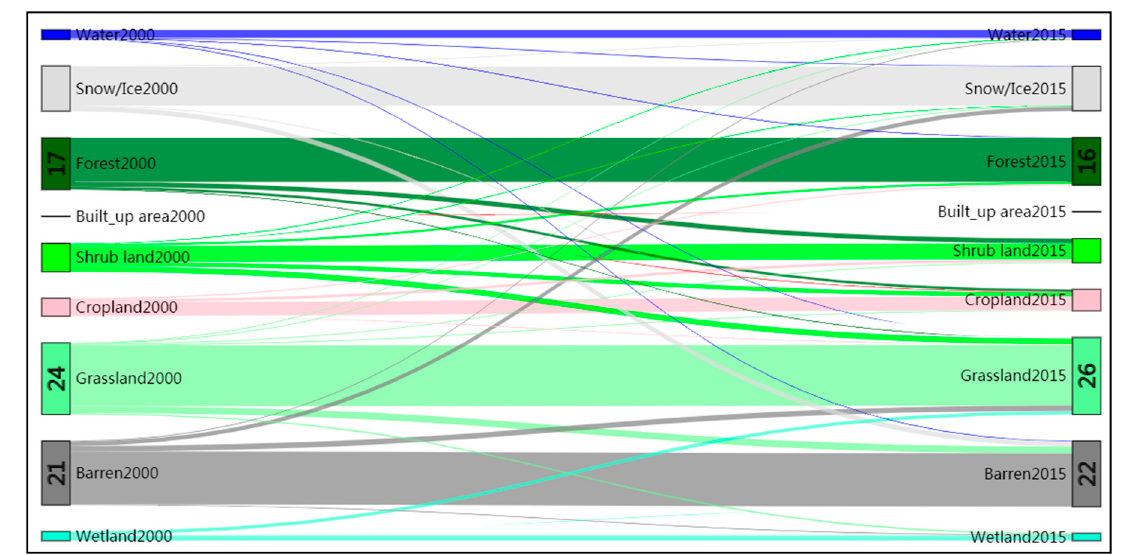
Figure 3. Sankey diagram of LULC transitions in the KSL during the period 2000–2015. The map was created using the tool at https://sankey.csaladen.es/#.